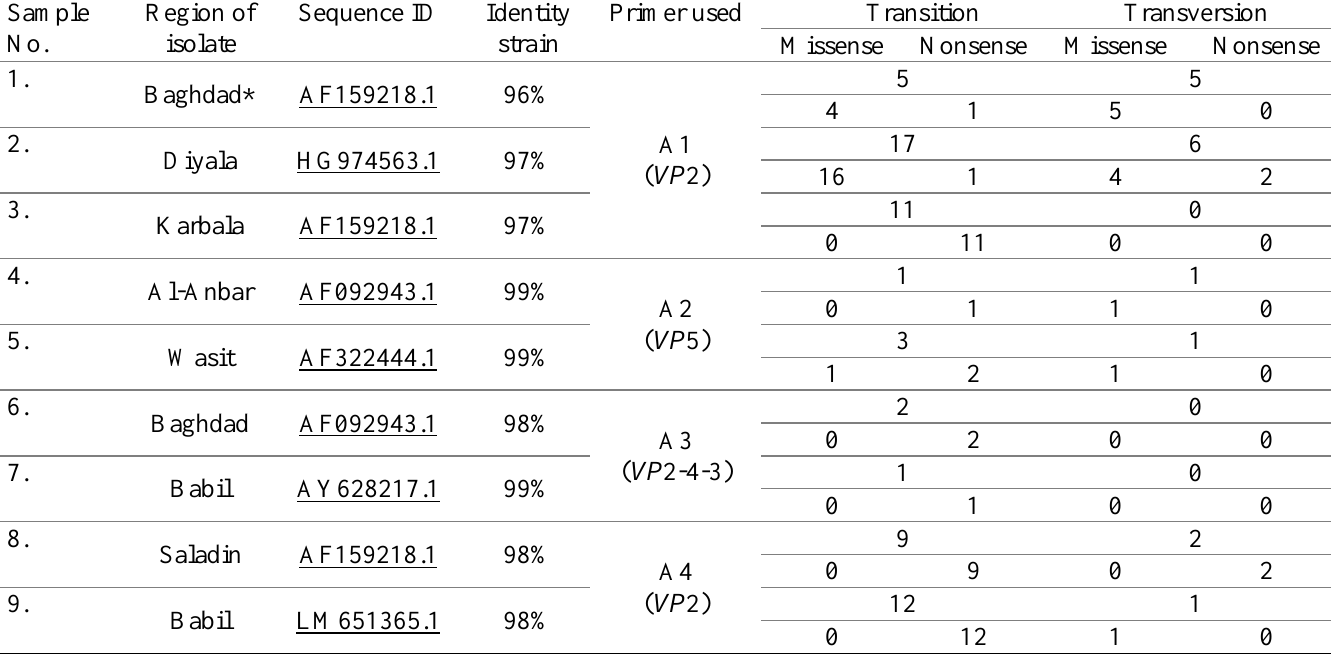
Table 2. Nucleotide changes of the sequences amplified from segment